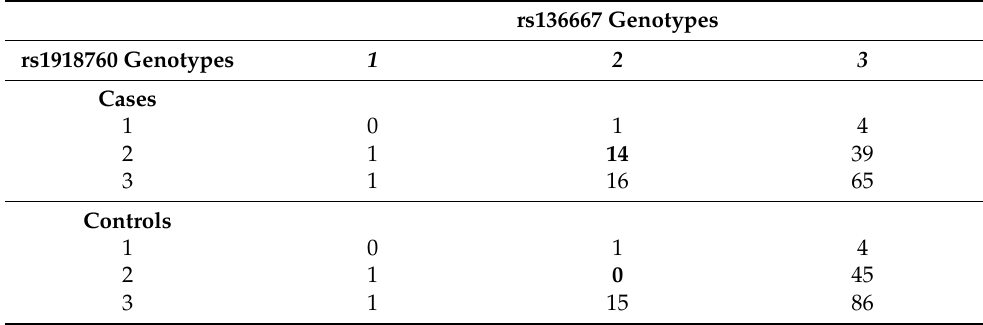
Table 2. Bivariate distribution of genotypes in the best genotype pattern for the Opioid dataset, separately for cases and controls. As shown in bold, the unique difference between cases and controls is the presence of pattern (2,2) in cases and its complete absence controls. The numbers of the other eight genotype patterns look comparable in cases and controls, so the effect of the (2,2) pattern could be “diluted” when contingency tables rather than genotype patterns are compared between cases and